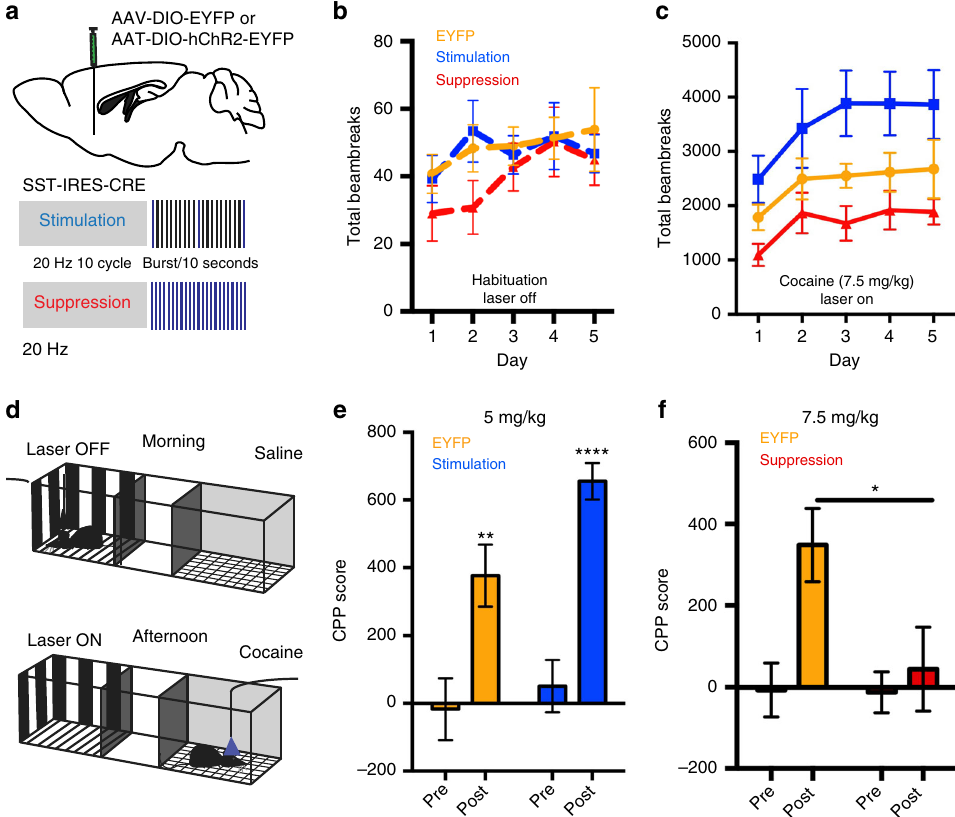
Fig. 1 NAc somatostatin interneuron activity regulates cocaine-induced locomotor activity and reward. a AAV-DIO-EYFP or AAV-DIO-ChR2-EYFP were injected bilaterally into NAc of Sst-Cre mice 3 weeks prior to optogenetic stimulation or suppression, respectively, with the following parameters: Stimulation (473 nm, 20 Hz frequency, 1 burst of 10 pulses, 4 ms pulse width, every 10 s) or Suppression (473 nm, 20 Hz frequency, 1 burst of 20 pulses, 49 ms pulse width, every sec). b There is no difference between the locomotor activity of the three groups during habituation while the lasers remain off (repeated measures two-way ANOVA: no effect of activity F (2,104) = 1.953. p = 0.147; n = 8,8,8) or day F (4,104) = 0.3617. p = 0.9383; n = 8,8,8). c The activity of NAc somatostatin interneurons (EYFP control, Stimulation, or Suppression) controls the locomotor activity of mice after repeated cocaine injections. There is a signi fi cant effect of activity (repeated measures two-way ANOVA: signi fi cant effect of activity F (2,21) = 5.647. p < 0.05; n = 8,8,8) and Day (Signi fi cant effect of Day F (4,84) = 8.856. p < 0.001; n = 8,8,8). d Experimental design for unbiased CPP with optogenetics. Groups were counterbalanced to ensure that cocaine was paired evenly in both the gray and striped sides of the CPP chambers. e Stimulation of NAc somatostatin interneurons enhances cocaine CPP (Student's t -test: EYFP Pre-test vs EYFP Post-test, ** p < 0.01; EYFP Pre-test mean = − 16.50 ± 91.33 SEM vs EYFP Post- test mean = 376.4 ± 91.33 SEM ( n = 8); CHR2-Stimulation Pre-test vs CHR2-Stimulation Post-Test, **** p < 0.0001 CHR2-Stimulation Pre-test mean